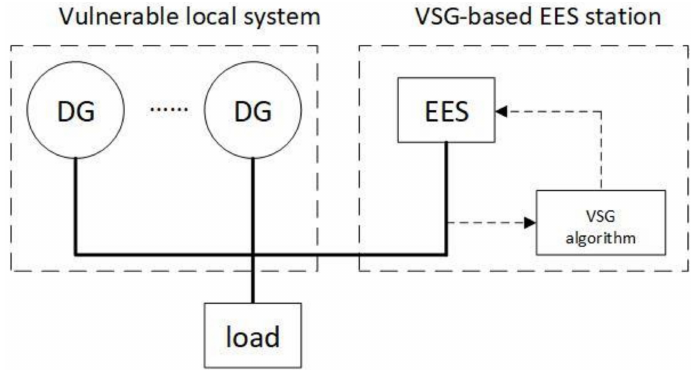
Figure 10. Schematic of a vulnerable AC system with an auxiliary VSG energy storage system (ESS).